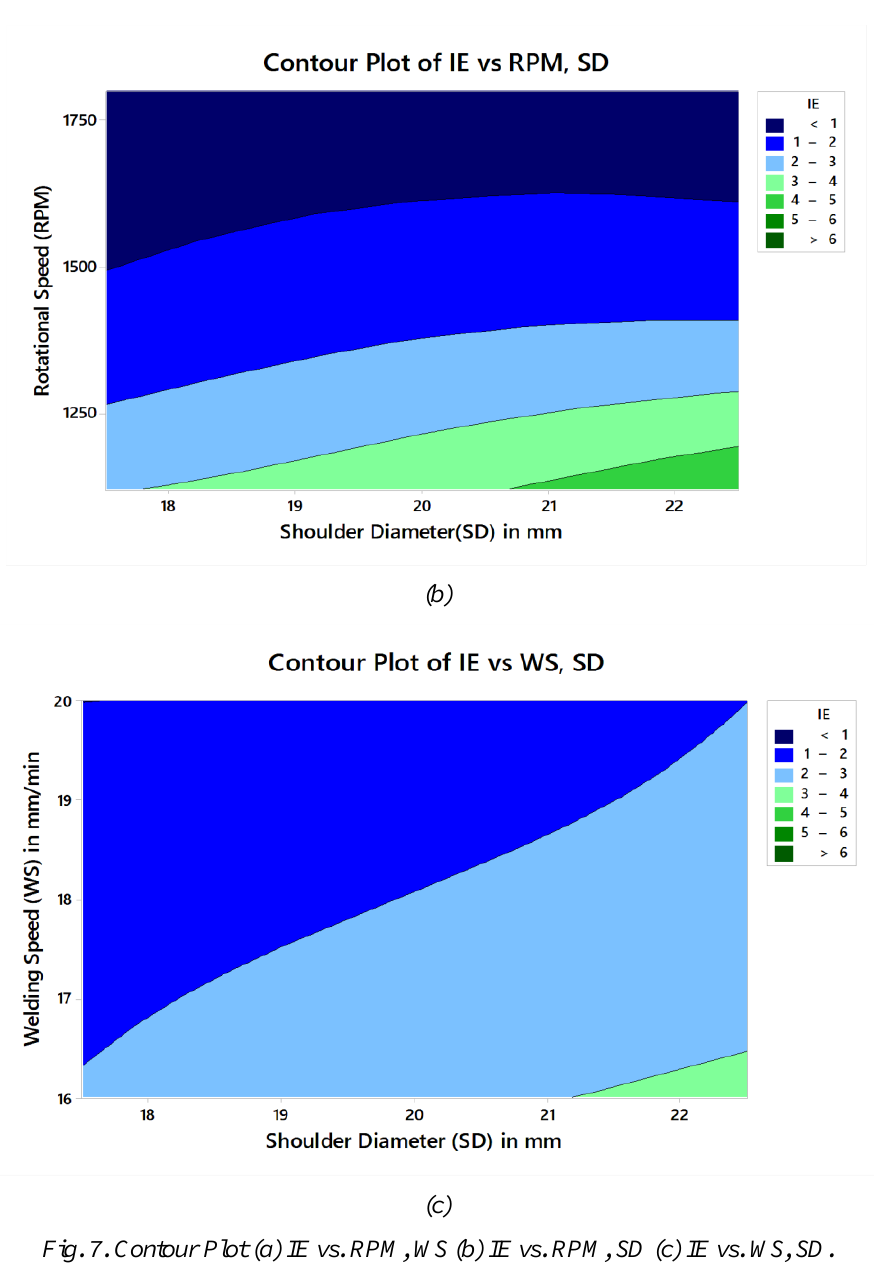
Fig. 7. Contour Plot (a) IE vs. RPM, WS (b) IE vs. RPM, SD (c) IE vs. WS,